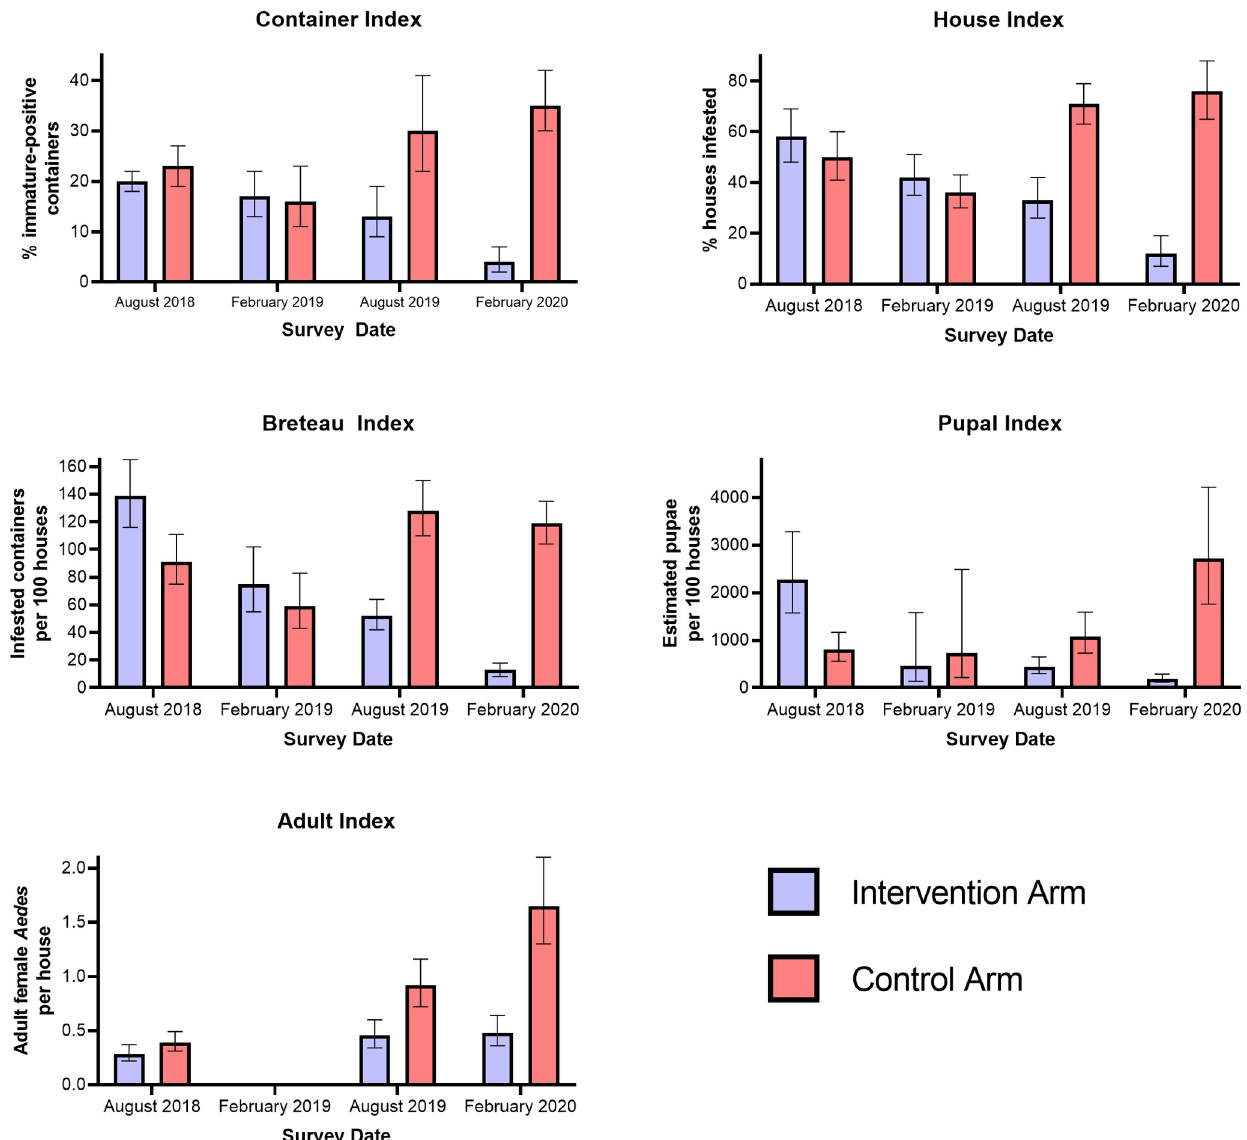
Fig 2. Container, House, Breteau, Pupal and Adult Indices for the Control and Intervention Arms by survey time point.